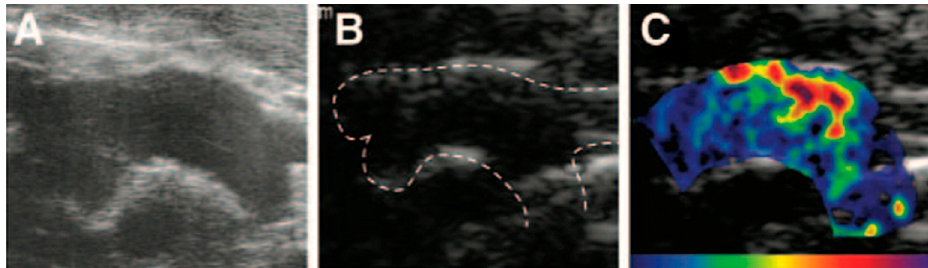
Figure 5. Illustration of spatial matching between morphology and targeted signal enhancement. ( A ) High-frequency ultrasound (40 MHz) image at the level of the aortic arch in a 10-week-old DKO animal; ( B ) Lower frequency multipulse contrast-specific imaging of the aorta at baseline, with the aorta defined by dashed lines, before contrast administration and ( C ) 10 min after administration of P-selectin–targeted microbubbles after background subtraction and color-coding (color scale at bottom). (Reprinted from Reference [220]. Copyright with permission from © 2010, Wolters Kluwer Health.)